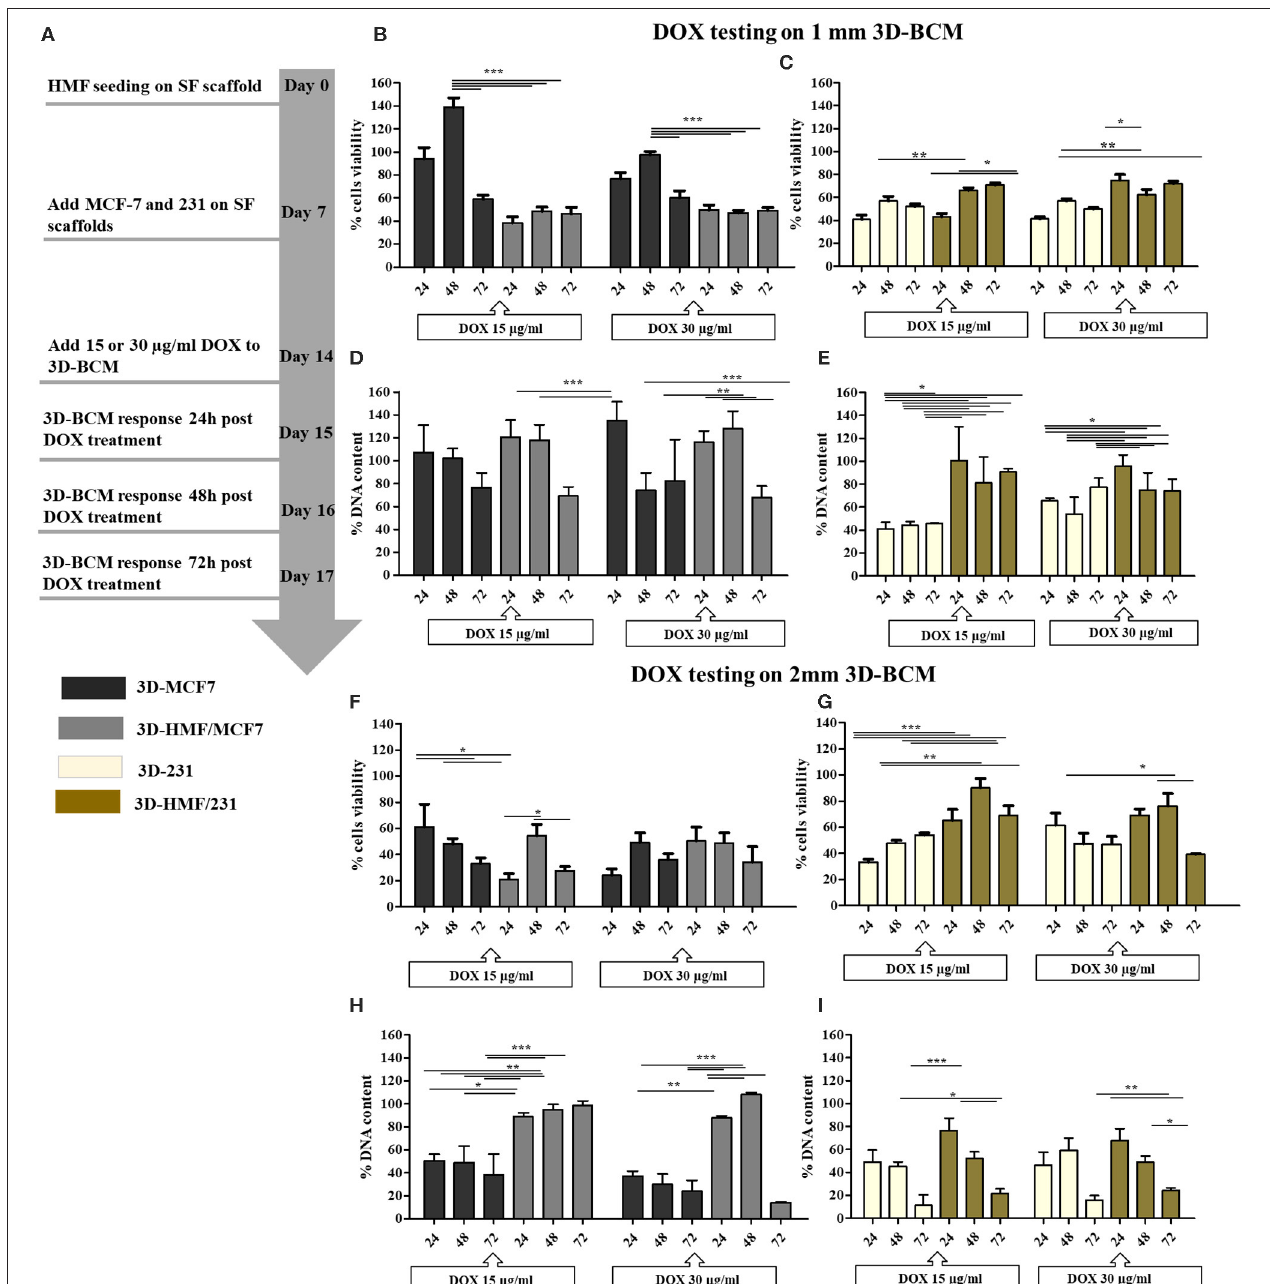
FIGURE 7 | DOX treatment on heterotypic 3D breast cancer model. (A) Schematic experimental workflow for the drug testing set-up. The DOX activity is evaluated at 24, 48, and 72h, starting on day 14 of 3D culture. Anti-proliferative effects of DOX on 3D-MCF7 and 3D-HMF/MCF7 (B,F) and 3D-231 and 3D-HMF/231 (C,G) was measured by mean of Alamar blue assay in 1 and 2mm SF scaffolds, respectively. Graphical representation of the amount of double stranded DNA (dsDNA) detected in 3D-MCF7 and 3D-HMF/MCF7 as well as in 3D-231 and 3D-HMF/231 after 24, 48, and 72h of DOX treatment [ (D,E) for 1mm plus (H,I) for 2 mm SF scaffolds]. P < 0.05 (*) is considered as statistically significant. ** p < 0.01, *** p < 0.001 ( n = 3).